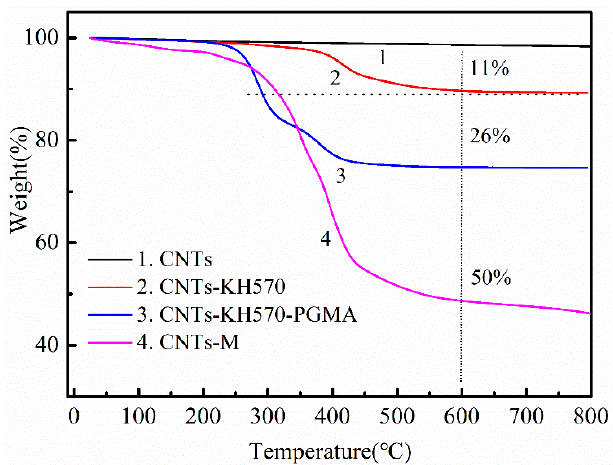
Figure 3. TGA curves of CNTs-KH570, CNTs-KH570-PGMA and CNTs-M.